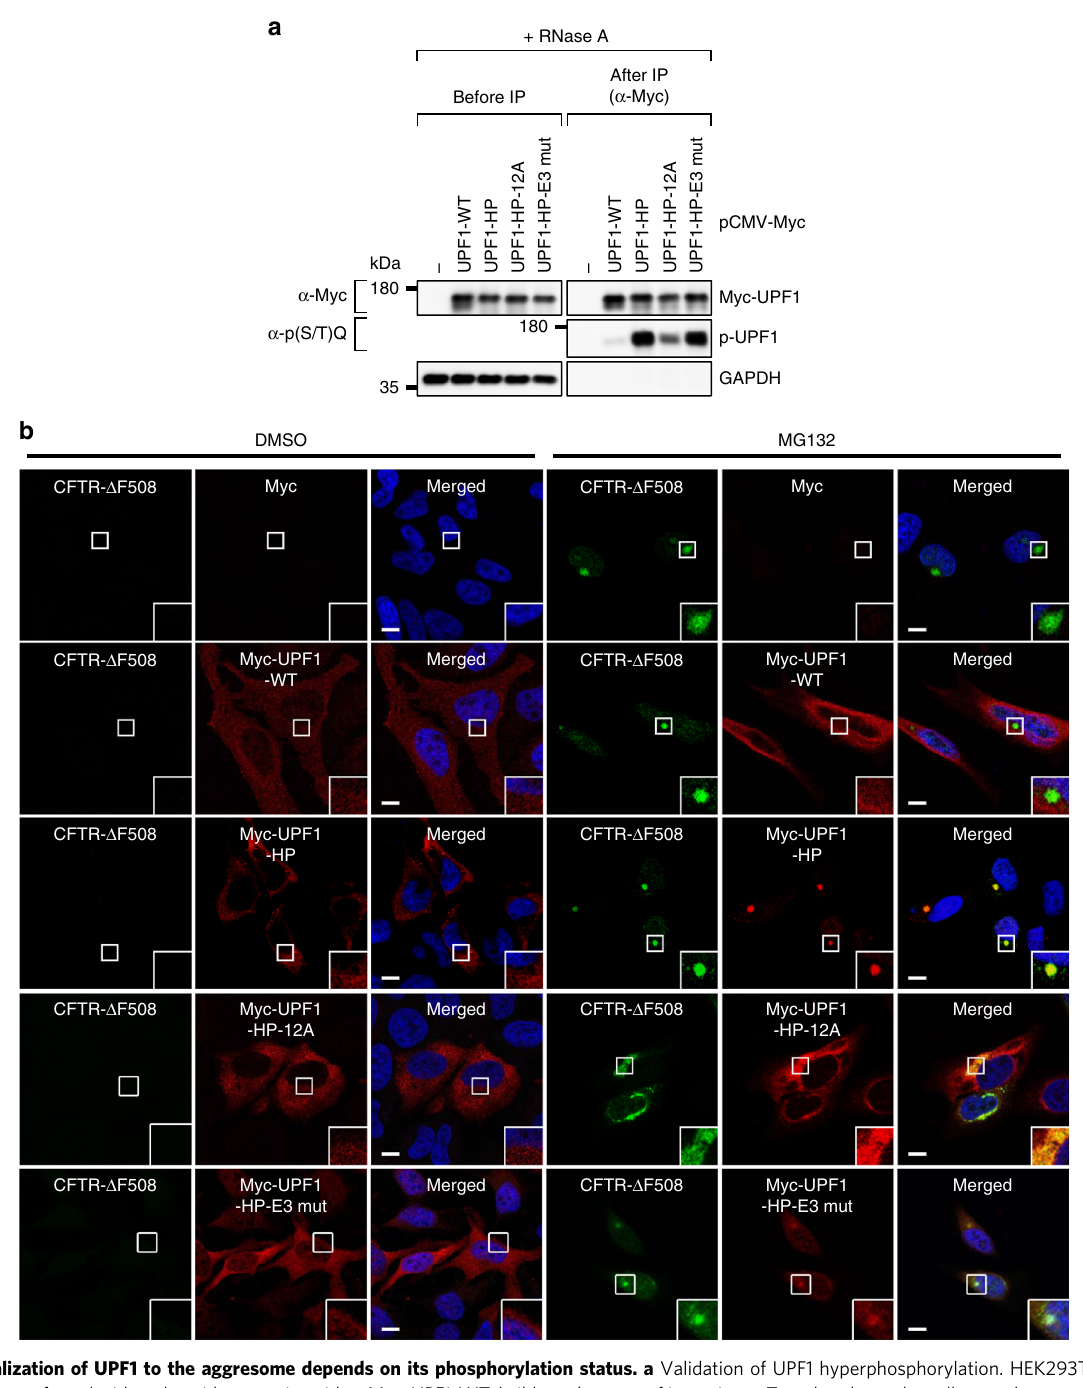
Fig. 3 Localization of UPF1 to the aggresome depends on its phosphorylation status. a Validation of UPF1 hyperphosphorylation. HEK293T cells were transiently transfected with a plasmid expressing either Myc-UPF1-WT (wild type) or one of its variants. Two days later, the cells were harvested. Next, the extract of cells was treated with RNase A before IPs and was subjected to IPs using the anti ( α )-Myc antibody. The samples before and after IPs were analyzed by western blotting; n = 2. Source data are provided as a Source Data File. b Immunostaining of CFTR- Δ F508 (green) and either Myc-UPF1-WT or its variants (red). HeLa cells stably expressing CFTR- Δ F508 were transiently transfected with the indicated plasmid expressing either Myc-UPF1-WT or one of its variants. Immunostaining images are representative of three independently processed biological replicates. Scale bar, 10 μ m; n =